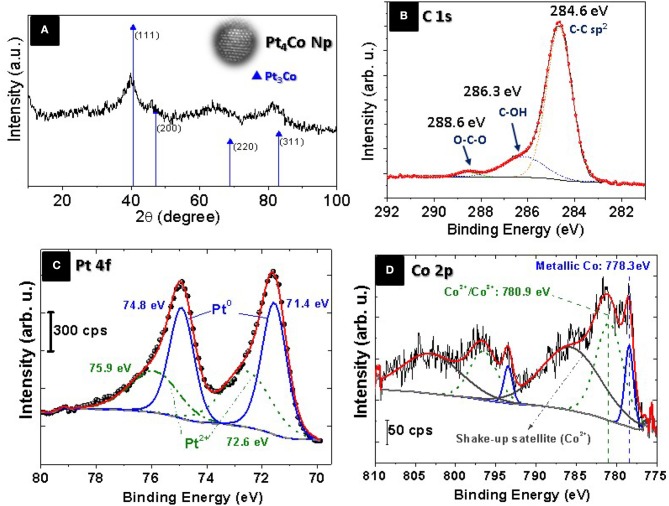
(A) XRD patterns of Pt4Co/C composite nanoparticles, and XPS spectra of: (B) C 1s region, (C) Pt 4f region and (D) Co 2p region showing the oxidation states of the Pt and Co in the Pt4Co/C composite nanoparticles.